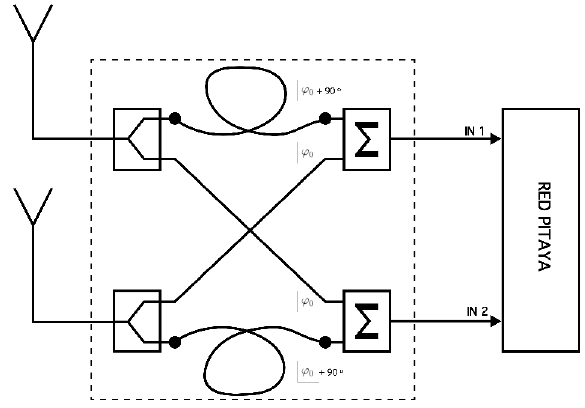
Figure 2. Phasing box of the receiver system.